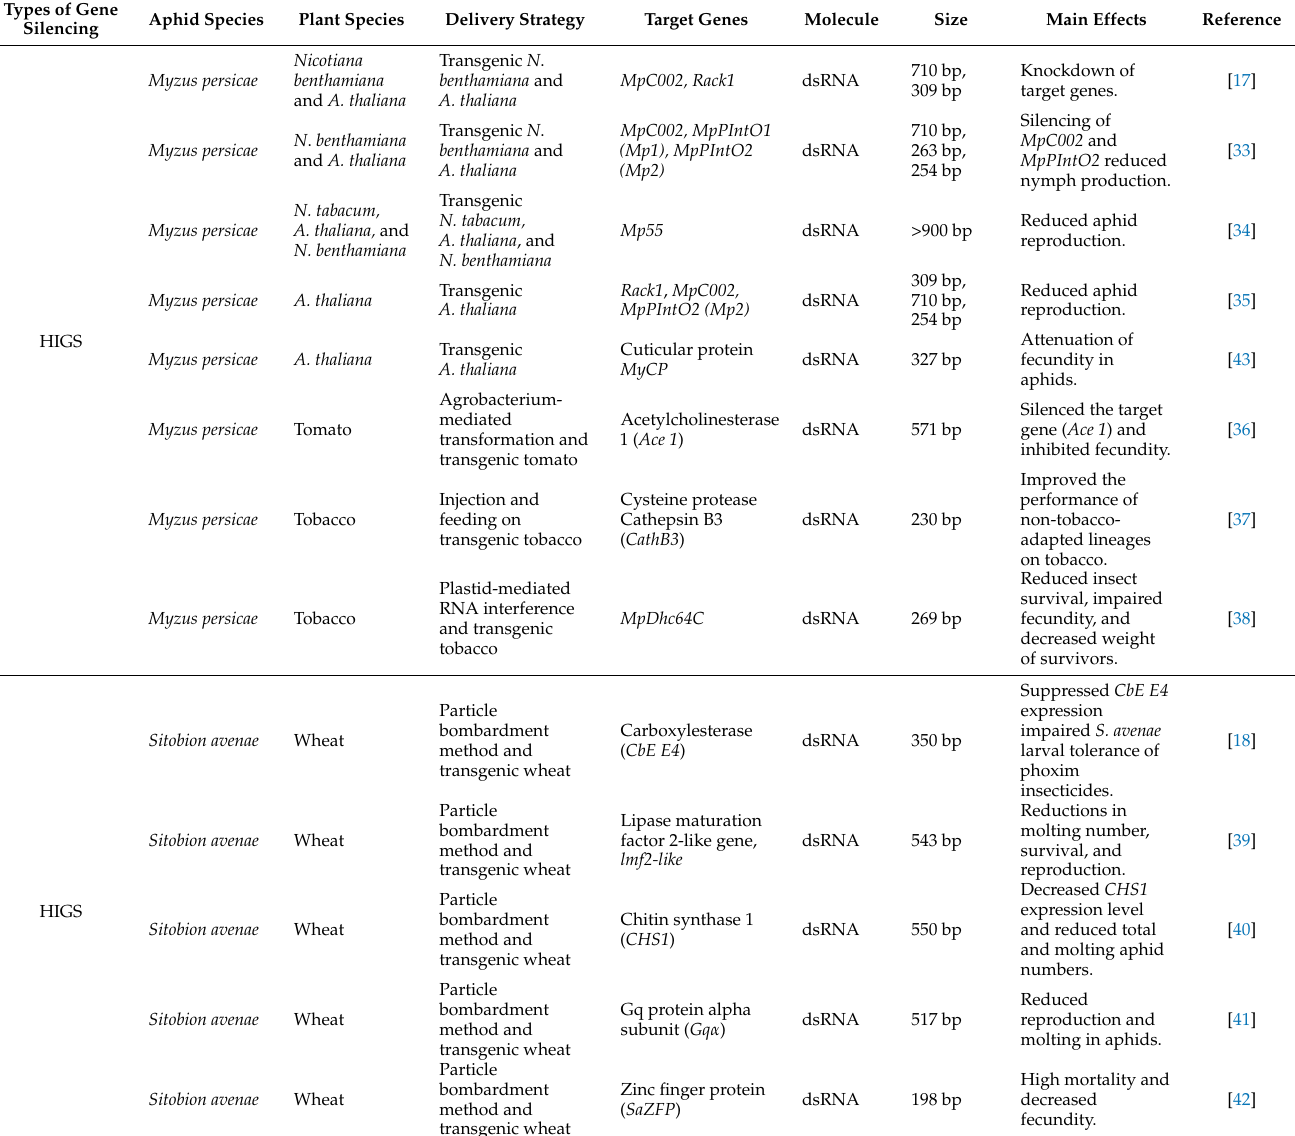
Table 1. Summary of RNAi application for aphid